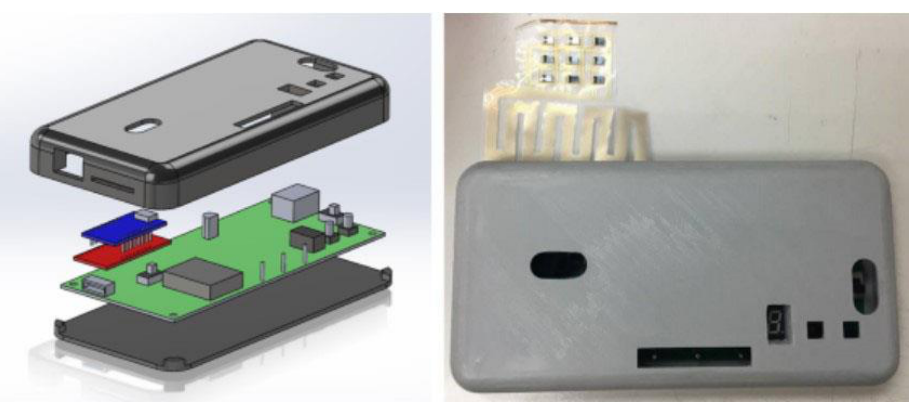
Figure 10. Illustration of the real 3D printing case.